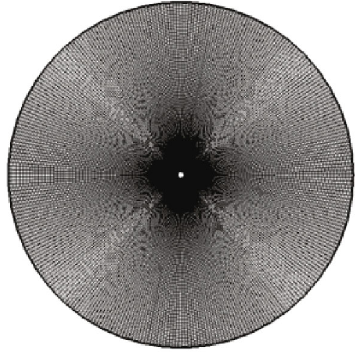
Figure 11: Meshing